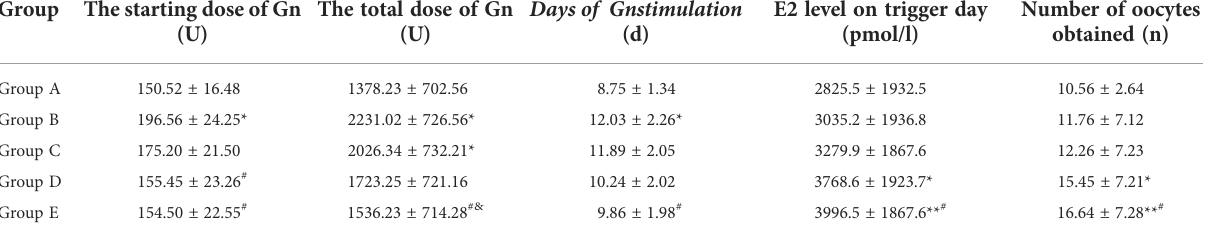
TABLE 5 Stimulation cycle characteristics.